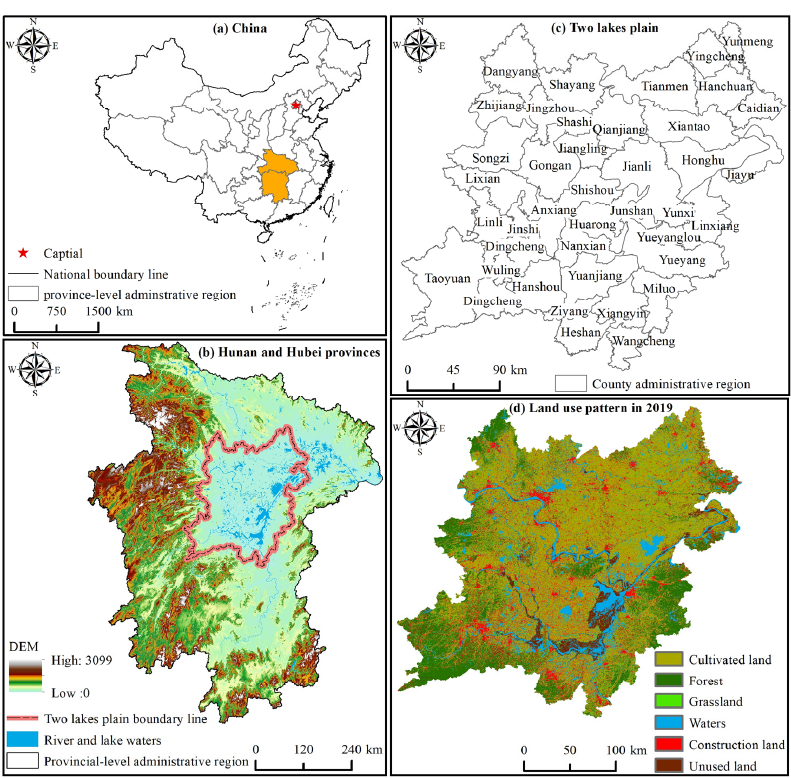
Figure 2. Topographic map of two lake plains and distribution map of County Administrative Region.